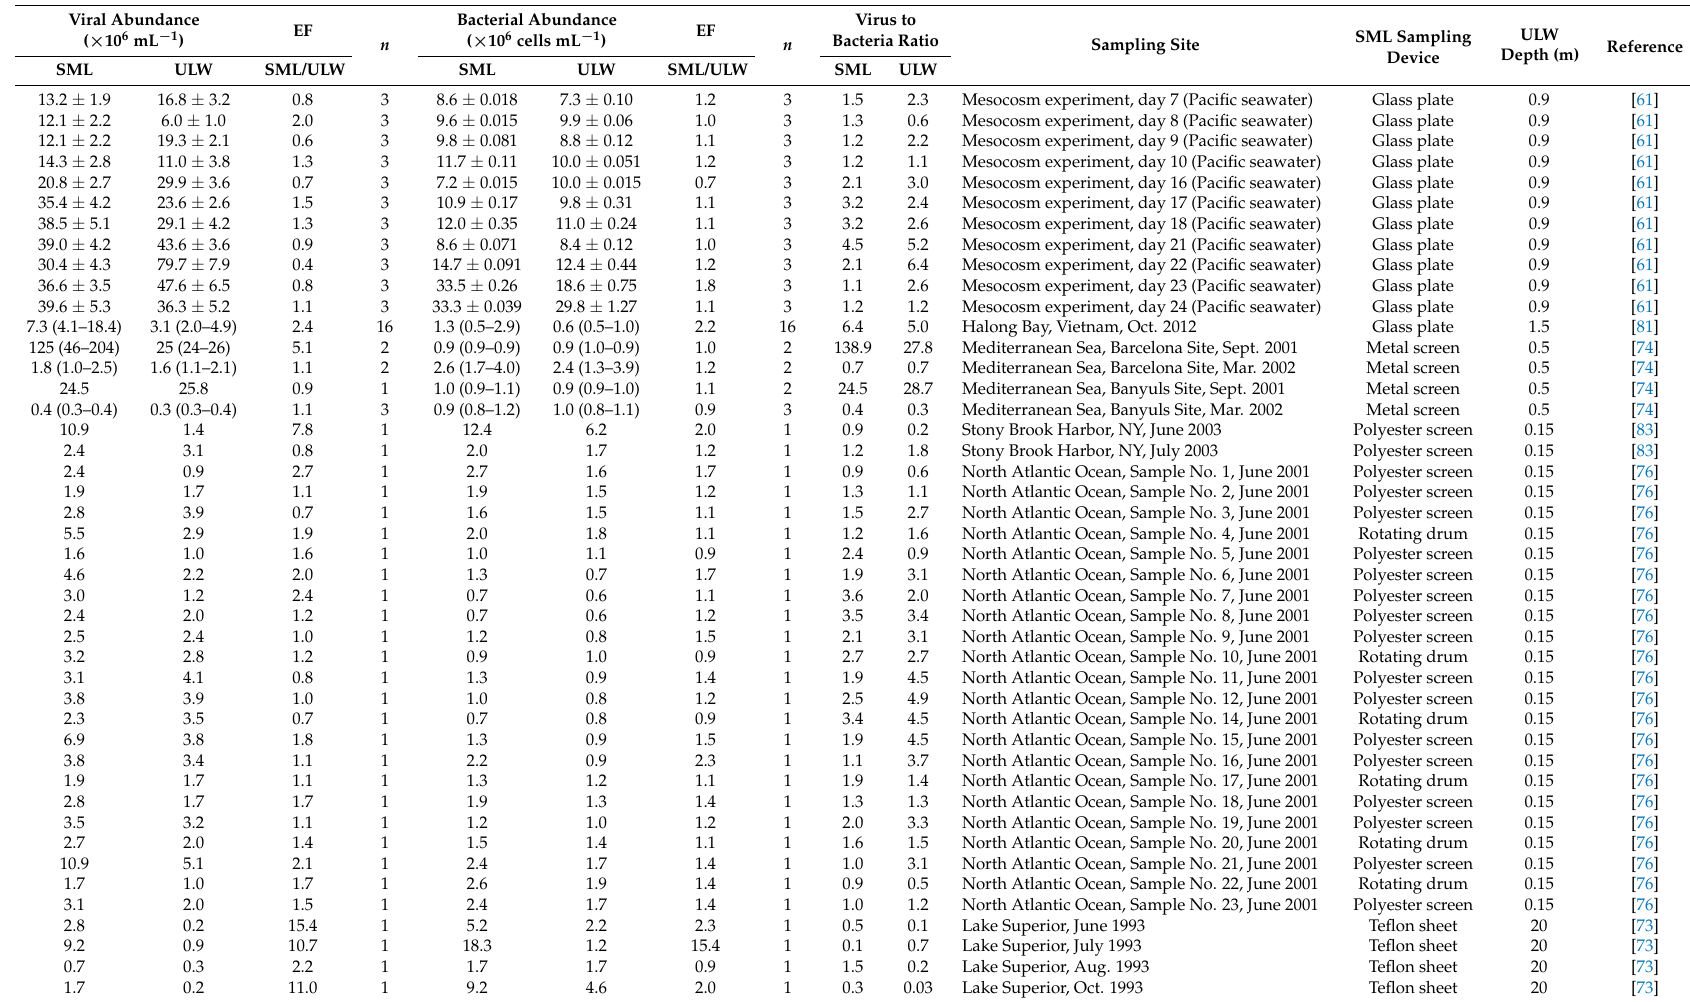
Table 1. Bacterial and viral abundances and ratios in the surface microlayer (SML) and underlying water (ULW). If n > 1, either ranges of minimum to maximum values are given in parentheses or ± standard deviation obtained from the reference source. EF = enrichment